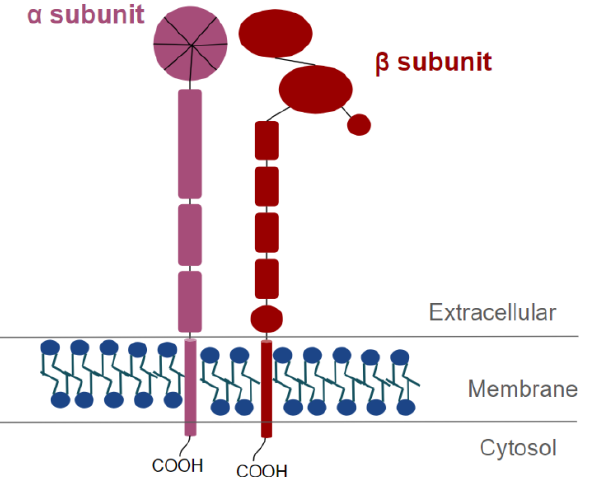
Figure 3. Schematic representation of an integrin heterodimer. In purple, the α subunit is represented, and in red the β subunit is represented.